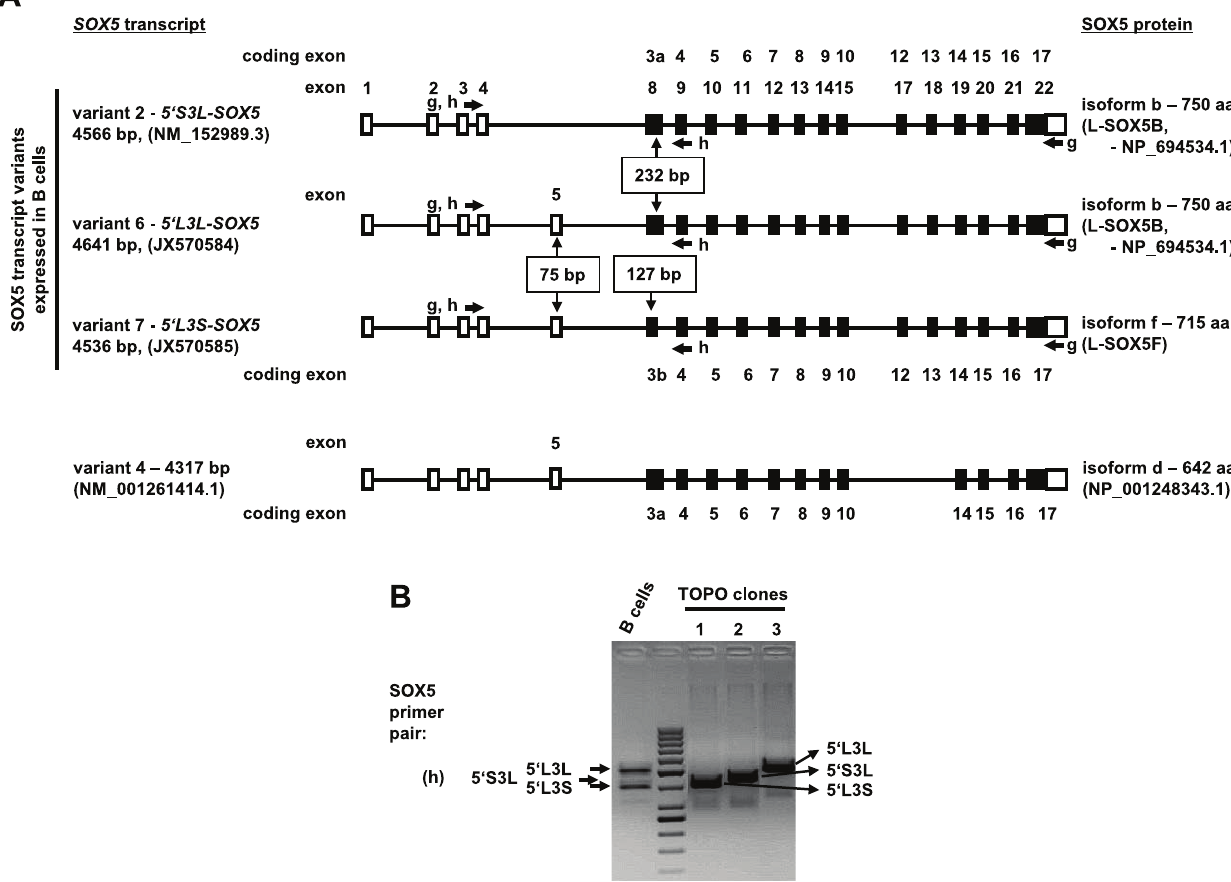
Figure 2. Human B cells express at least three different transcript variants of SOX5 . (A) Schematic representation of sequence verified human SOX5 transcript variants in B lymphocytes. Non-coding exons are depicted as open rectangles, partial coding exons - as half open rectangles and coding exons - as filled rectangles. Cloning primer locations are indicated with appropriate arrows. Exons and coding exons are numbered according to their location along the genomic sequence, which are drawn as black lines. (B) PCR analysis of SOX5 transcript expression in B cells and in single clones picked for sequence analysis. B lymphocytes express at least three different SOX5 transcript splice variants as evidenced by representative single TOPO clones 1, 2 and